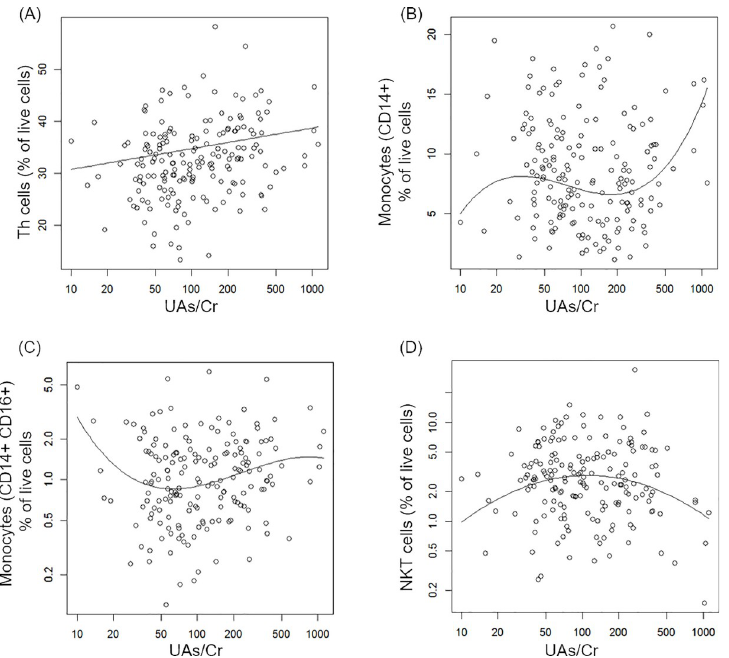
Fig 1. Covariate-adjusted associations between UAs/Cr and cell surface markers. Individual data points represent observations; solid lines represent estimated mean outcome vs. UAs/Cr adjusted for other variables in the model. The outcomes (A-B) were Th (CD4+) cells and monocytes (CD14+) and outcomes (C-D) were a subset of monocytes (CD14+CD16+) and NKT cells in logarithmic